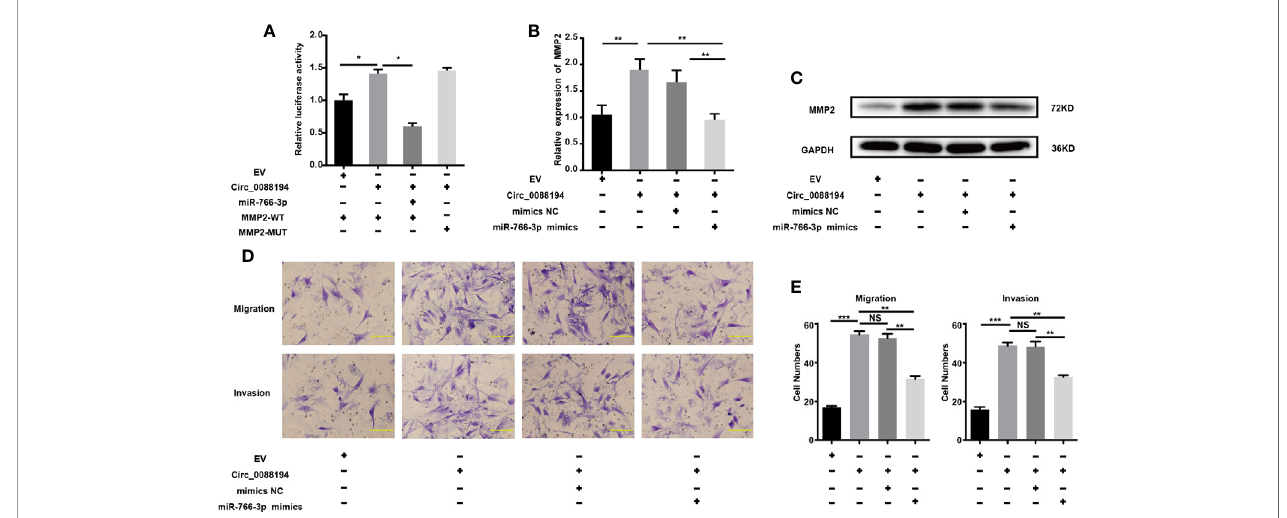
FIGURE 6 | Circ_0088194 promotes RA-FLSs migration and invasion via miR-766-3p/MMP2 axis. (A) The increased luciferase activity of WT-MMP2 treated with Circ_0088194 adenovirus was blocked by co-transfection with miR-766-3p mimics. (B) In RA-FLSs, the MMP2 mRNA levels were determined using qRT-PCR. MiR- 766-3p mimics and Circ_0088194 adenovirus were co-transfected into RA-FLSs. (C) Western blotting analysis of MMP2 protein levels in RA-FLSs. RA-FLSs were co-transfected with miR-766-3p mimics and Circ_0088194 adenovirus. (D, E) The migratory and invasive ability of RA-FLSs. RA-FLSs were co-transfected with miR- 766-3p mimics and Circ_0088194 adenovirus. Scale bar, 500 µm. Data are shown as mean ± SD. NS, not signi fi cant. *indicates p < 0.05, **indicates p < 0.01, and ***indicates p <